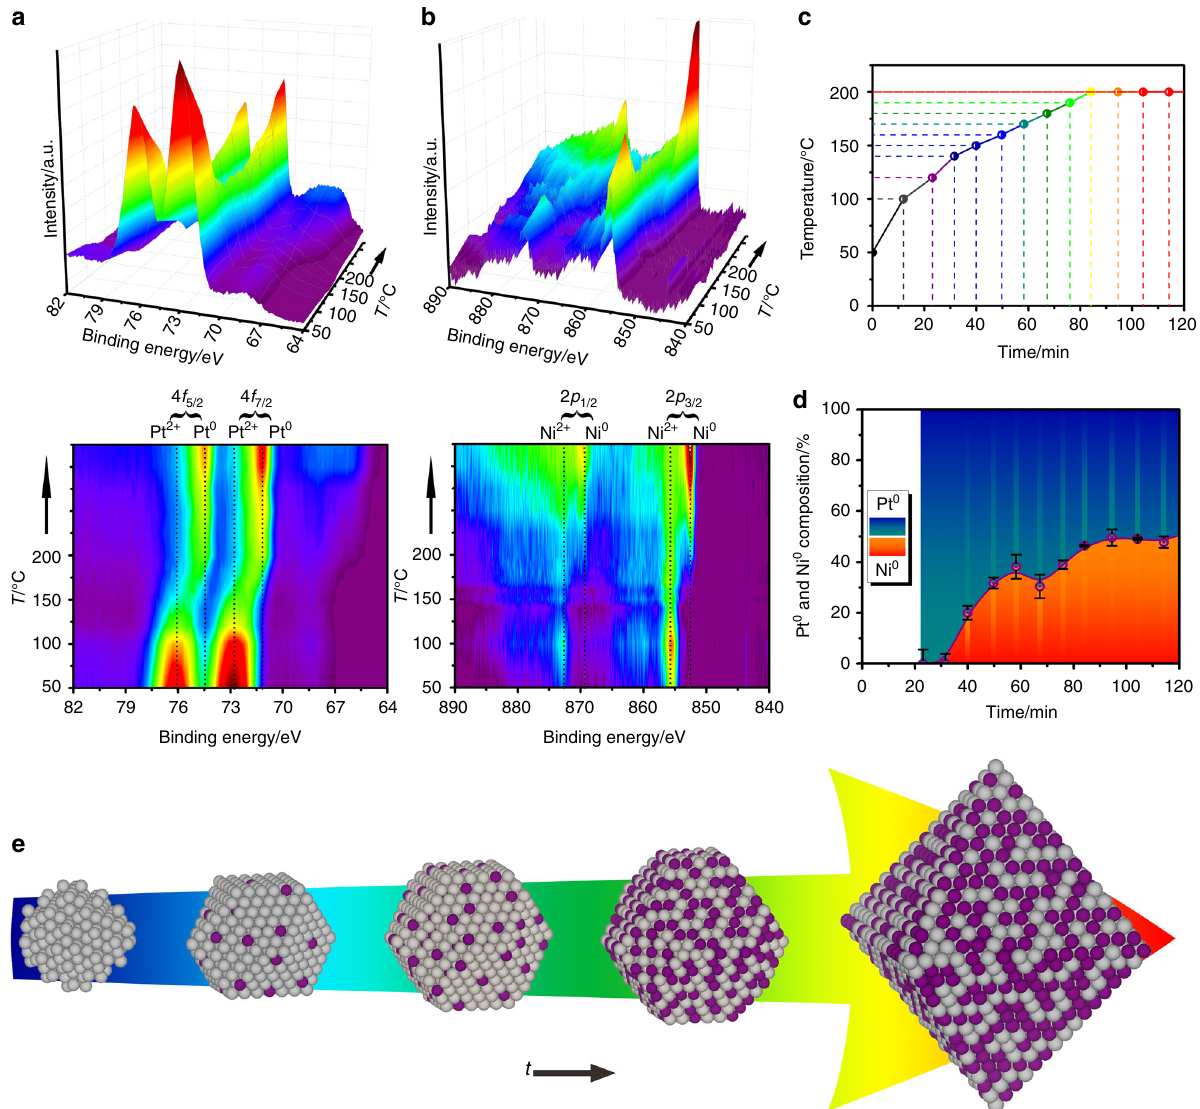
Fig. 2 Surface composition evolution of the growing Pt 3 Ni nanoparticles. a Pt 4 f and b Ni 2 p AP-XPS spectra and corresponding 2D projections of growing particles. c Temperature pro fi le as a function of experiment time. d Calculated Pt 0 and Ni 0 contents near surface region of the growing particles based on quantitative XPS analysis (Error bars correspond to standard deviations of at least three independent composition analysis). e Growth model (not to scale) of Pt 3 Ni nanoparticle with near surface Pt 0 /Ni 0 ratio changes (gray: Pt; purple: